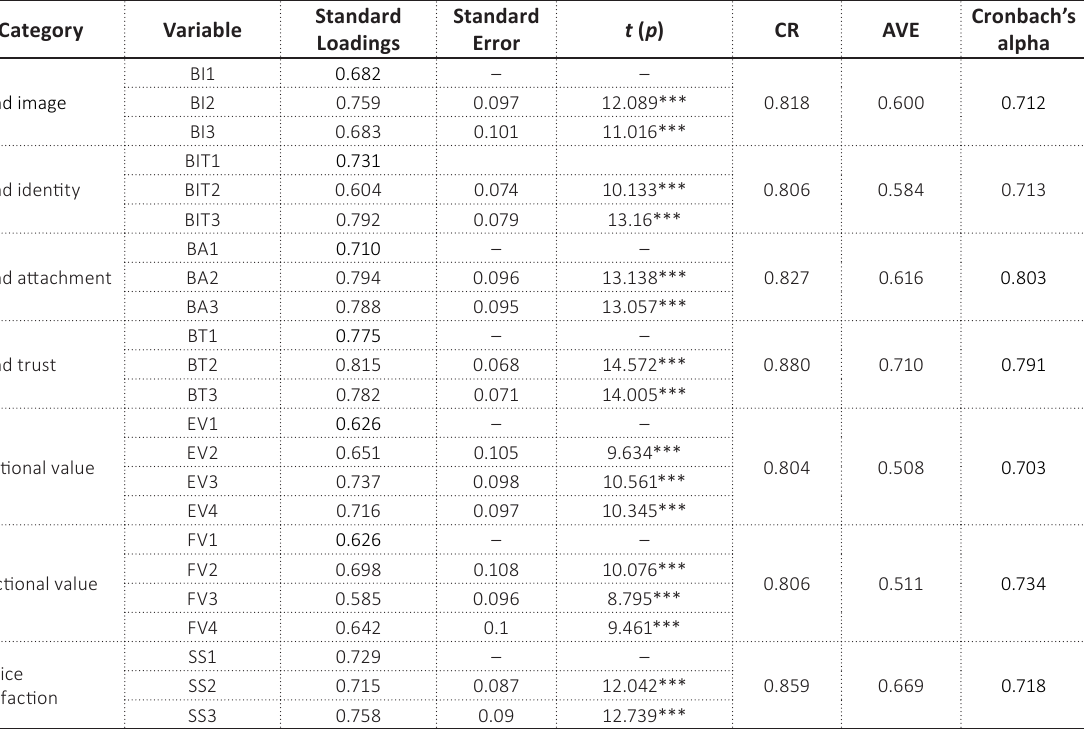
Table 2. Results of reliability and convergent validity test